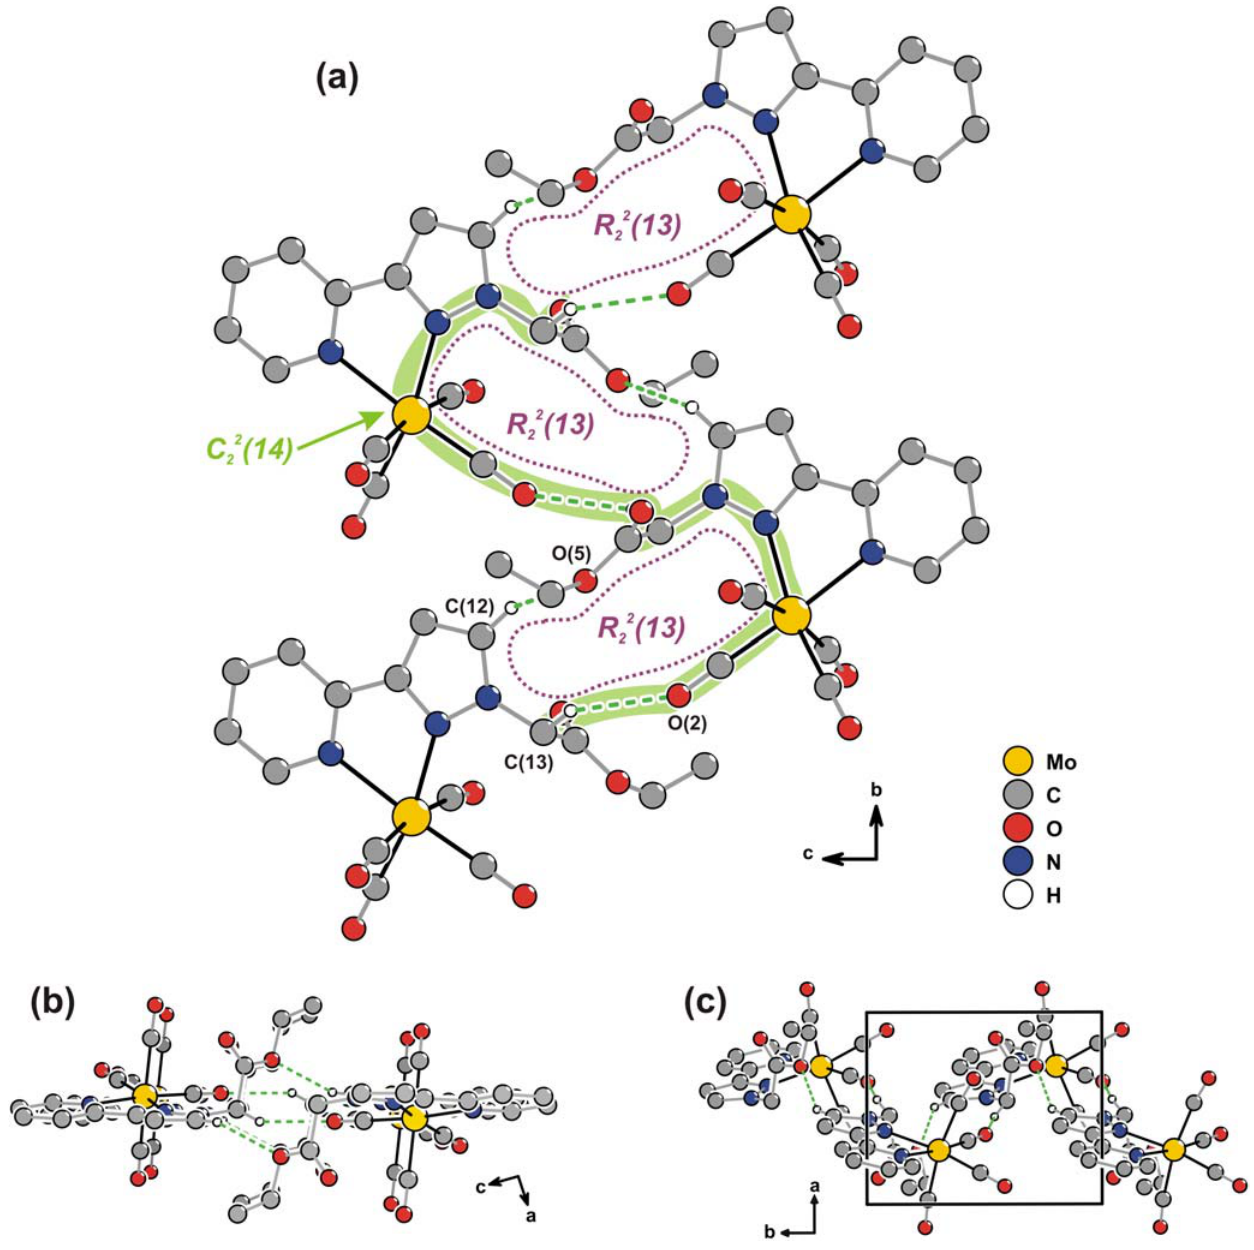
Figure 2. Schematic representation, viewed along the three crystallographic directions ( i.e. , (a) [100], (b) [010] and (c) [001]), of the weak C–H···O hydrogen bonding interactions (represented as dashed green lines) between neighbouring cis -[Mo(CO) (pzpy)] complexes, which lead to the formation of 4 a supramolecular tape running parallel to the b - axis of the unit cell. Hydrogen atoms which are not involved in the aforementioned interactions and symmetry codes of symmetry-generated atoms mentioned above have been omitted for